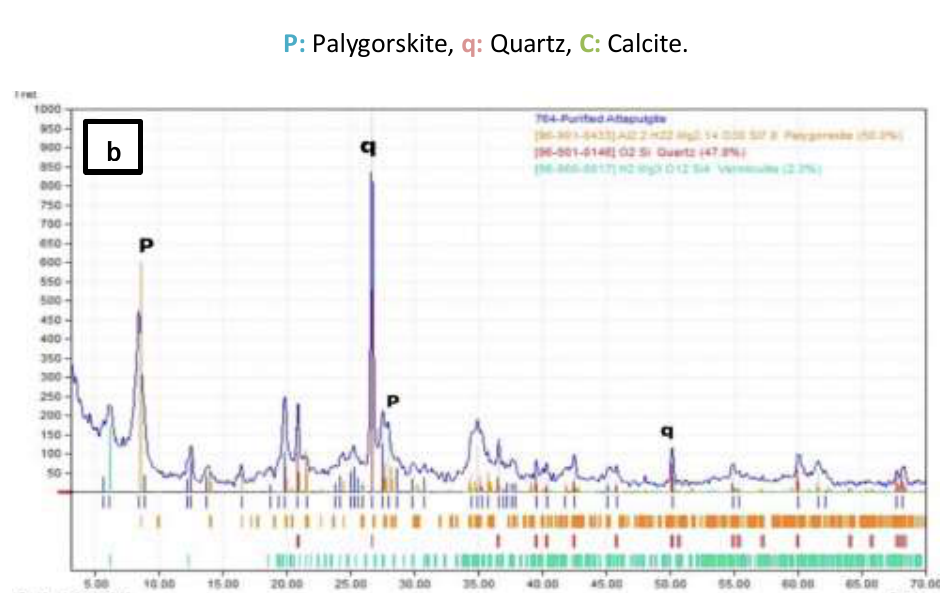
Figure 3: Mineral analysis a) for untreated (with calcite) clay b) for treated attapulgite